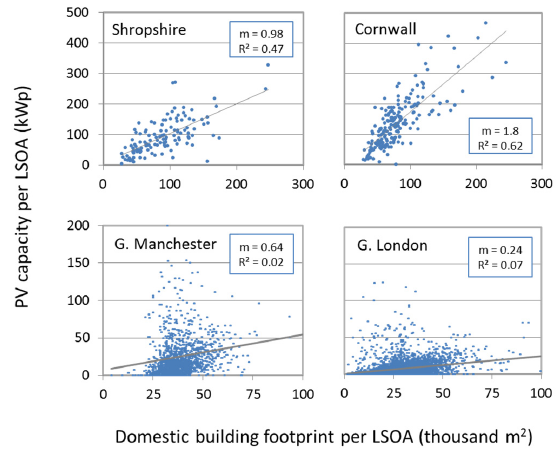
Figure 6. Domestic PV capacity against building footprint per lower ‐ layer super output area (LSOA). Insets show gradient (m) and R ‐ squared values.